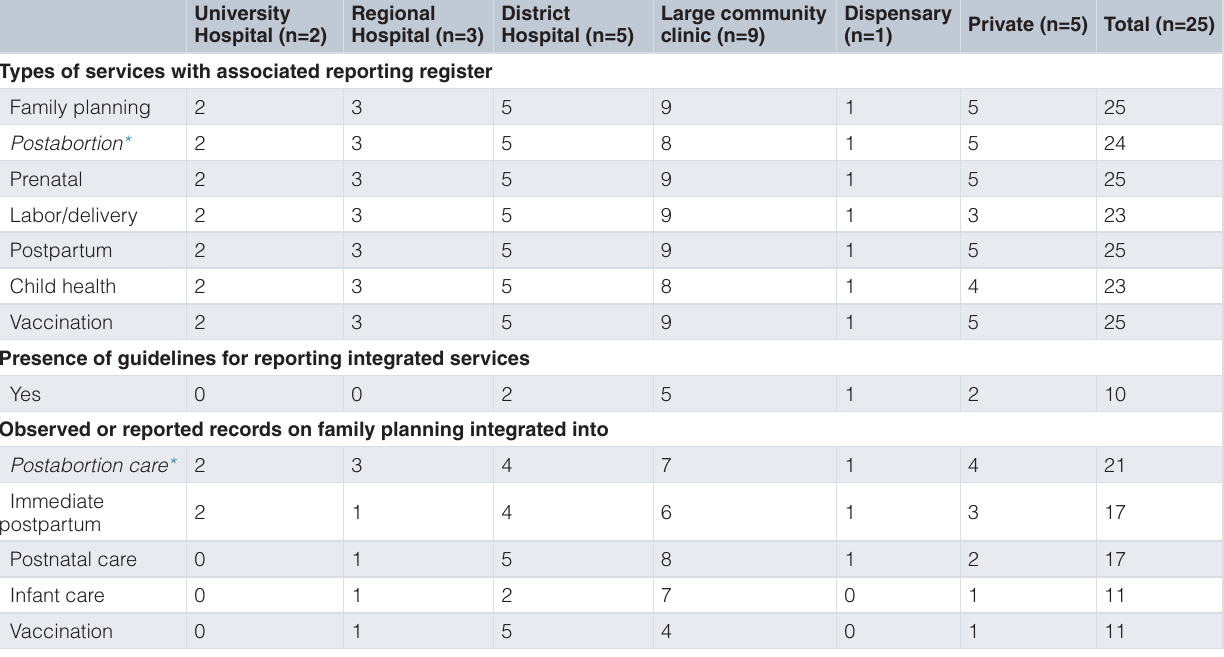
Table 1. Types of services provided, presence of reporting guidelines, and reporting tools for integrated